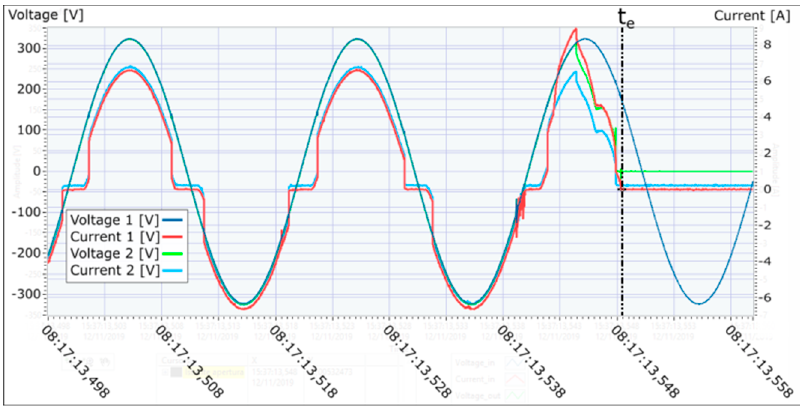
Figure 11. Instant ( t e ) at which the circuit was opened by the AFDD (using the Bourns 2049-12 surge arrester).